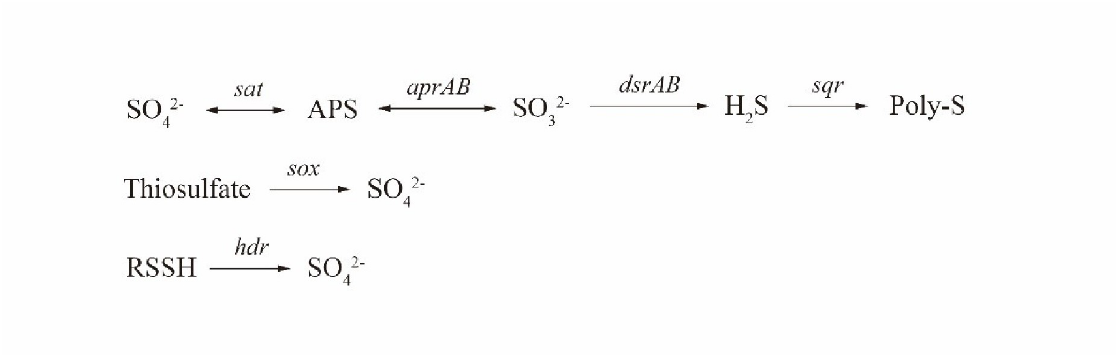
Fig 4. Internal cycling of sulfur through the cooperation of enzymes encoded by sulfate reduction and sulfur oxidation genes.